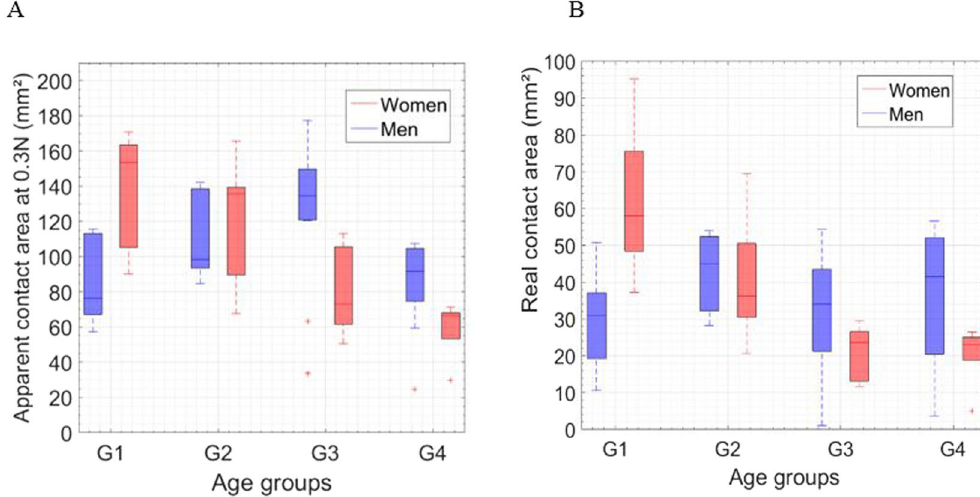
Figure 7. ( A,B ) The apparent and real contact areas as a function of age and gender respectively, captured on video. The four age groups (G1, G2, G3, and G4) correspond to (26 ± 3, 35 ± 3, 45 ± 2, and 58 ± 6 years old), respectively, for men and women. Pearson’s statistical analyses: ( + for r > 0.8, − for r < − 0.8) highly correlated, (0) for no correlation, R indicates the correlation results, * p < 0.05 for statistically significant.